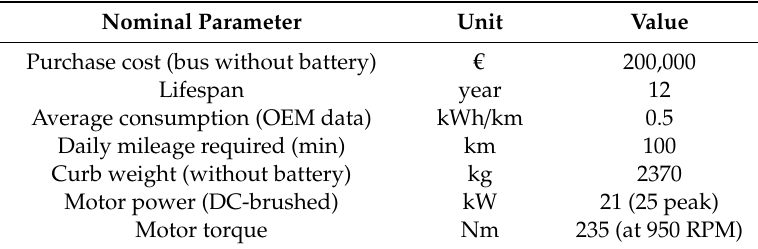
Table 4. Bus nominal specifications.